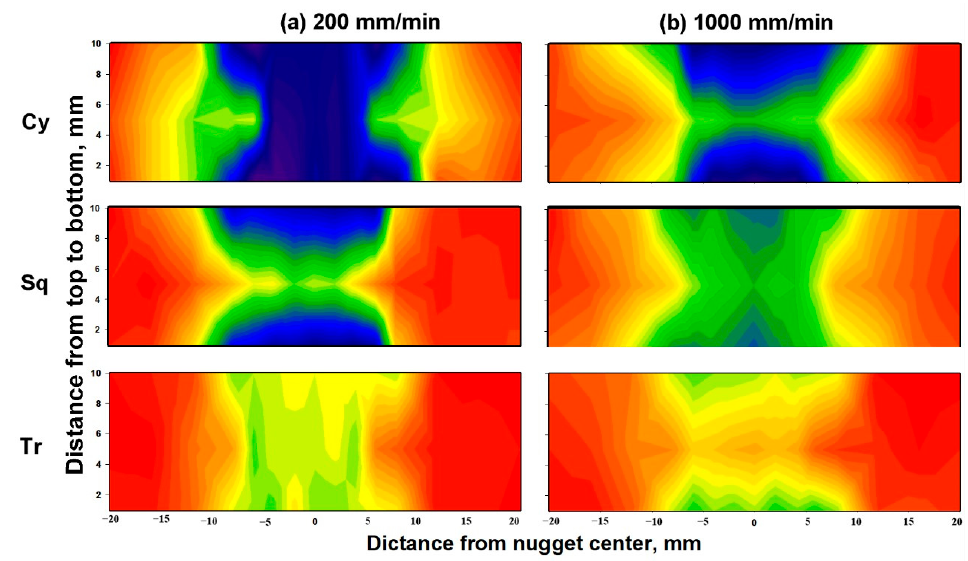
Figure 20. Hardness maps obtained at the transverse cross-section of the BT-FSWed lap joints at ( a ) 200 mm/min and ( b ) 1000 mm/min, using different pin geometries (Cy, Sq, and Tr). The tensile-shear load of BT-FSW lap joints using the different pins (Cy, Sq, and Tr) at various travel speeds of 200, 400, 600, 800, and 1000 mm/min, at a constant rotation speed of 600 rpm, was plotted in Figure 21. For all the applied pin geometries, the tensile- shear load increases with decreasing travel speed, reaching its peak value at 200